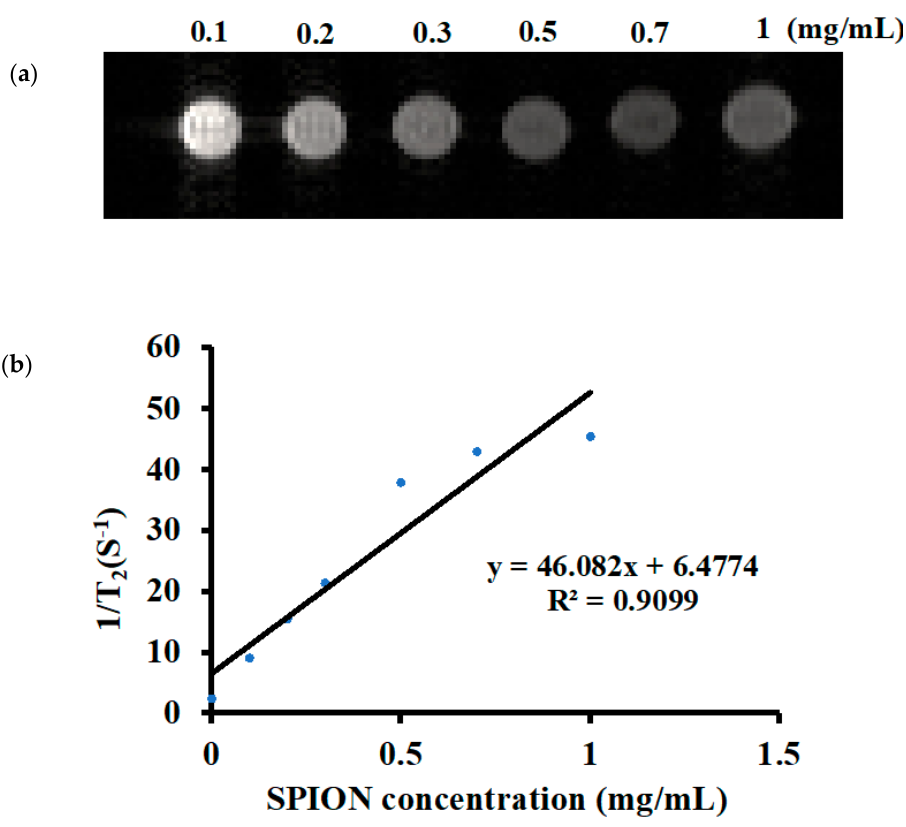
Figure 4. ( a ) T 2 -weighted magnetic resonance images at six D-SPION concentrations; ( b ) linear fitting of relaxation rate (1/T 2 ) versus D-SPION concentrations. The relaxivity values of r 2 were calculated from the slope of the graph.